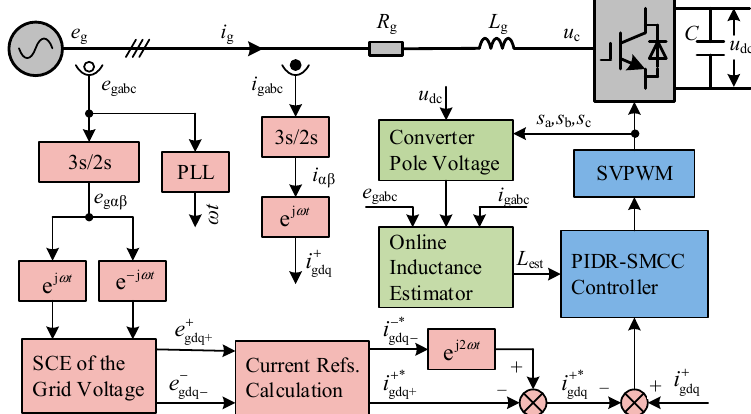
Figure 6. Block diagram of the proportional-integral-derivative-resonant law-based sliding mode current control strategy with online inductance estimator (PIDR-SMCC-OIE).